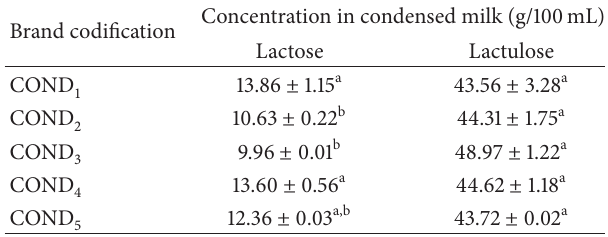
Table 2: Concentrations of lactose and lactulose found in five different commercial brands of condensed